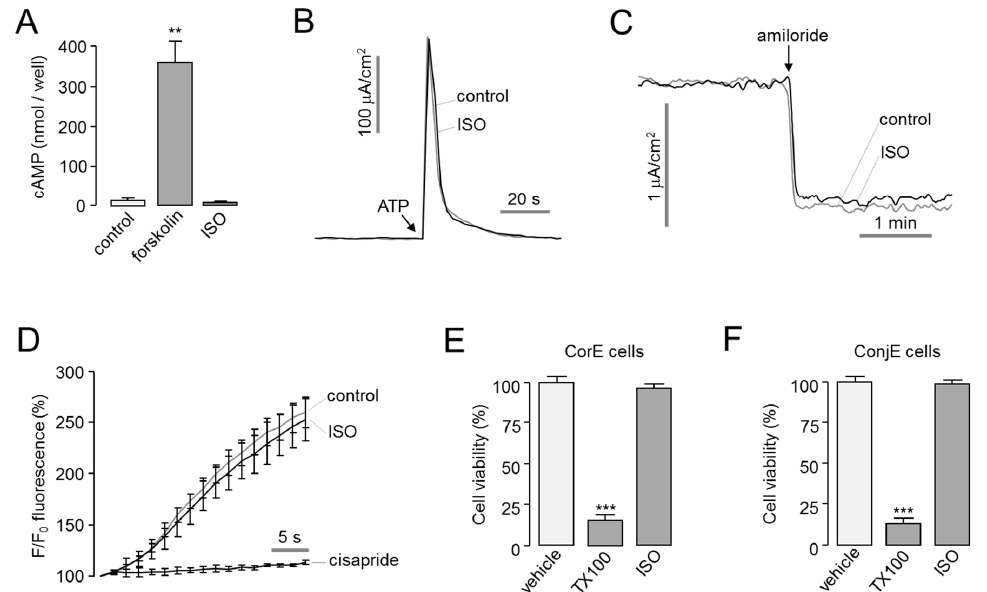
Figure 2. Characterization of isorhamnetin. ( A ) cAMP accumulation in FRT cells in response to addition of isorhamnetin (30 μ M) and forskolin (20 μ M) (mean ± S.E., n = 3–4). ( B ) Apical membrane currents were measured in FRT-ANO1 cells. Isorhamnetin 30 µ M was added 10 min prior to ANO1 activation by 100 µ M ATP. ( C ) Effect of isorhamnetin on ENaC activity was observed in T84 cells. Isorhamnetin 30 µ M was applied 10 min prior to ENaC inhibition by 100 µ M amiloride. ( D ) Effect of isorhamnetin on hERG potassium channel activity was measured in HEK293T cells expressing hERG (mean ± S.E., n = 3). Isorhamnetin 30 µ M was pretreated for 10 min. The hERG channel was inhibited by 50 µ M cisapride. ( E , F ) CorE and ConjE cells were treated with isorhamnetin (30 µ M) for 48 h and cell viability was determined by MTS assay. Triton X-100 (TX100, 0.01%) was used as a positive control (mean ± S.E., n = 4–6). ** p < 0.01, *** p <